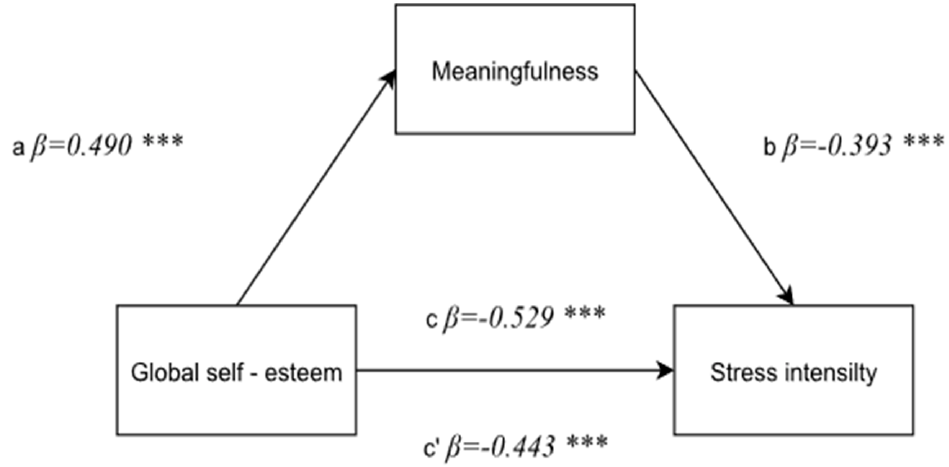
Figure 5. A model of the mediatory role of a sense of manageability between global self-esteem and the stress intensity. Statistically significant: *** p < 0.001.